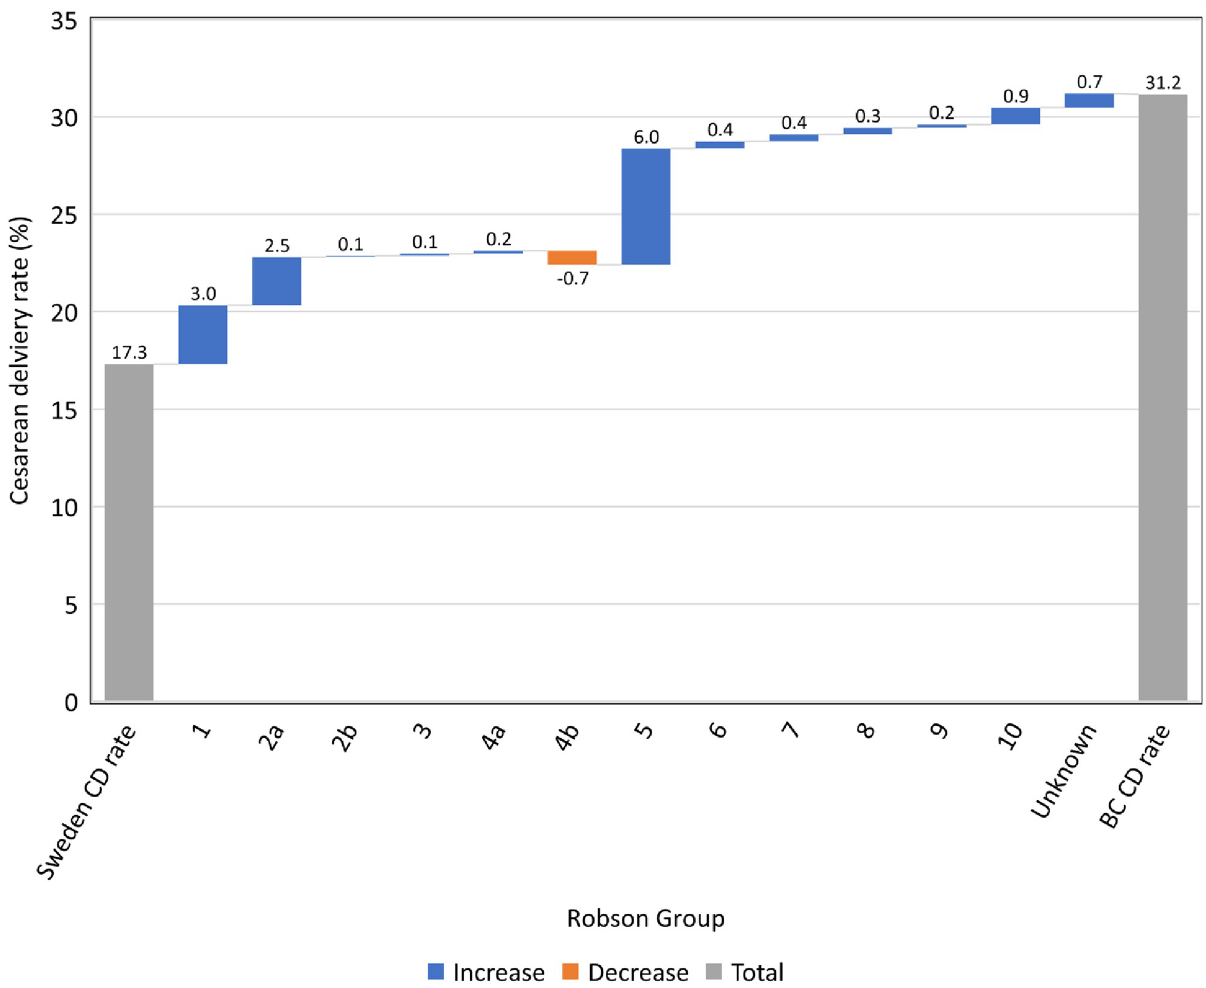
Fig 3. Cumulative difference in rate of CD (per 100 deliveries) in BC, Canada vs. Sweden, by Robson group, 2004–2016. BC, British Columbia; CD, cesarean delivery.